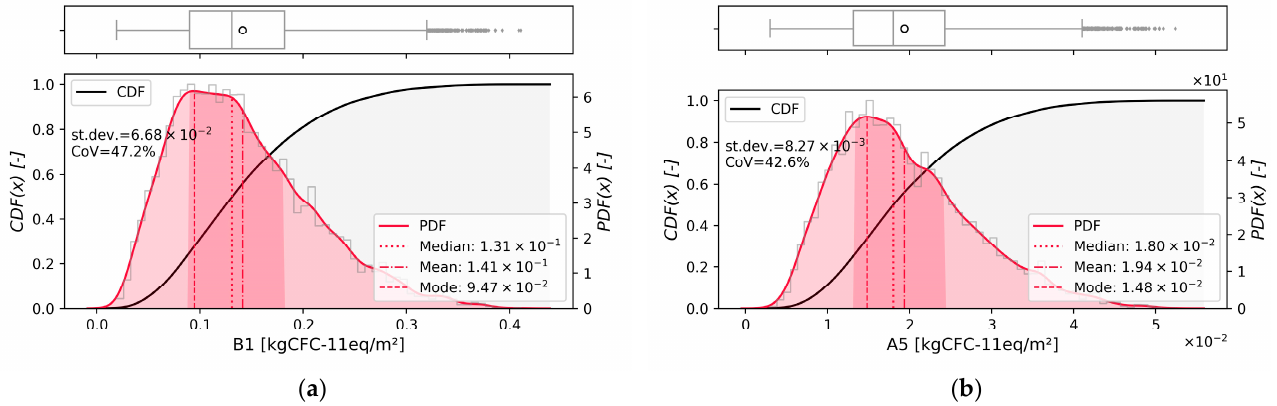
Figure 10. PDFs, CDFs, and box-whisker plots for the LCA results in terms of the main ODP impacts for: ( a ) Existing building and A-S1; ( b ) B-S1.